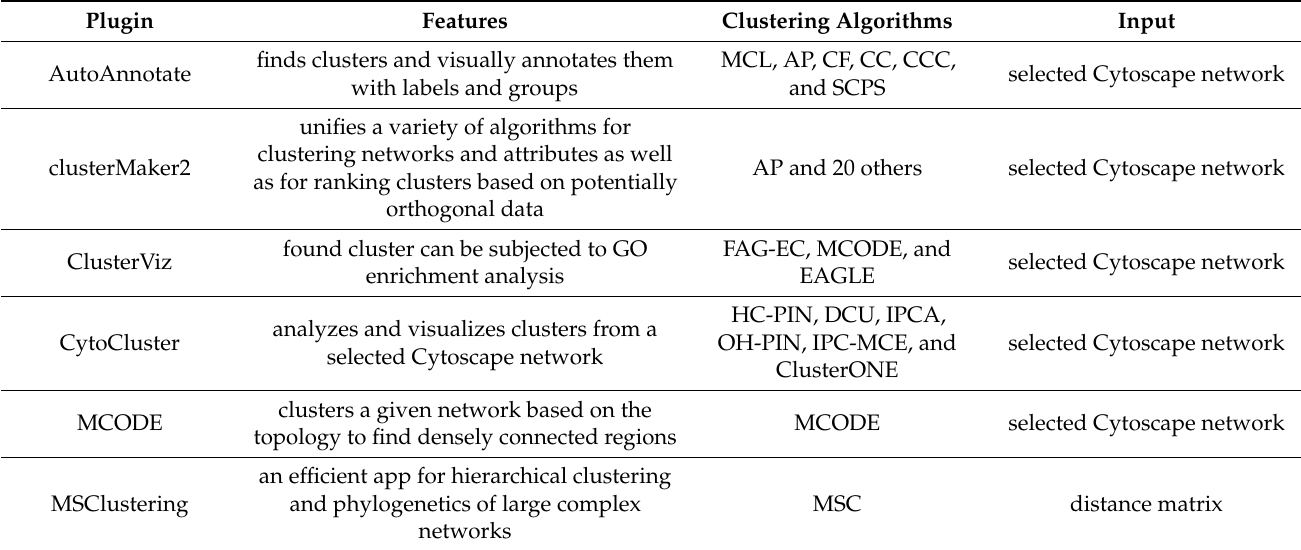
Table 2. A high-level comparison of the five most popular clustering plugins in Cytoscape with